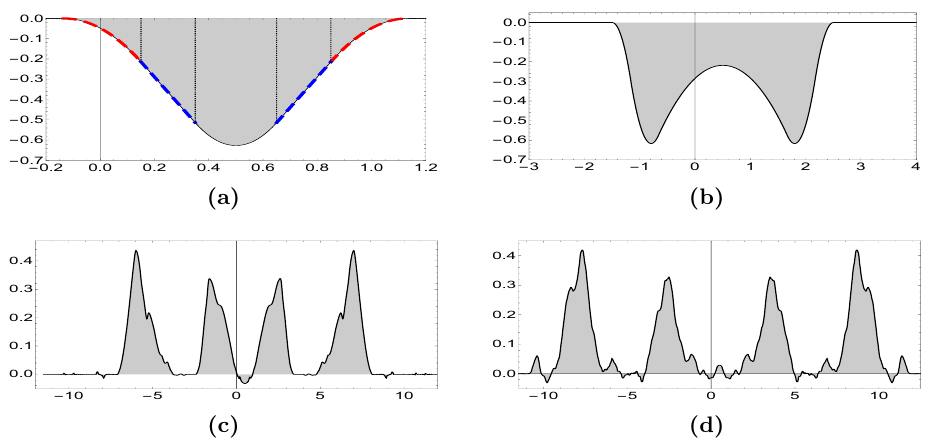
Figure 6. Numerical perturbed breather solution (shadowed region under solid line) and self- similar exact solution (dashed lines) for (cid:15) = 10 : 0. Snapshots correspond to (a) t = 0 : 15, (b) t = 1 : 67, (c) t = 20 : 79, (d) t = 41 :